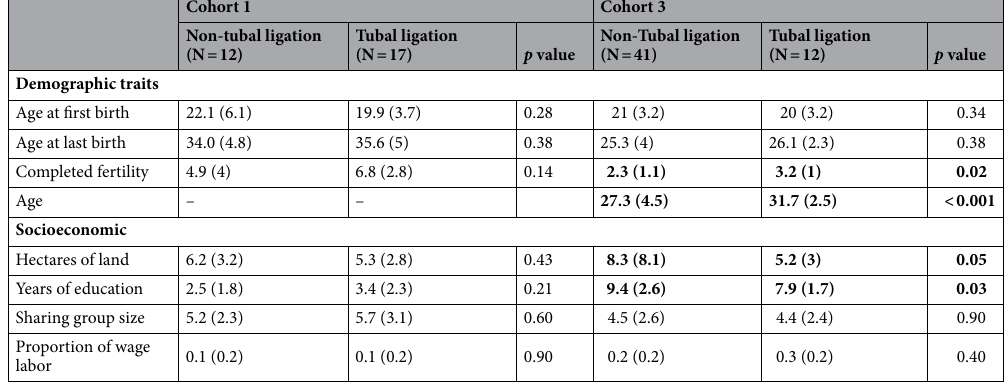
Table 4. Comparison of Women with and without tubal ligations. Table does not include comparisons for Cohort 2 because 16 out of 17 women who had children received a Tubal Ligation. Comparisons excludes nulliparous women since they do not tubal